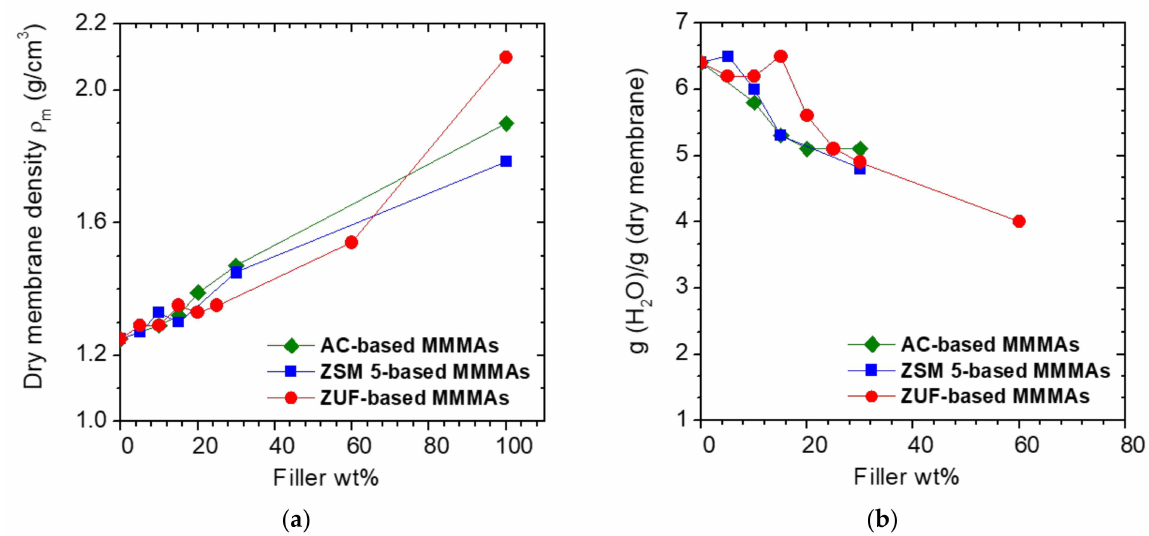
Figure 4. ( a ) Dry membrane density ρ m and ( b ) Water uptake, in grams of water per gram of dry membrane, versus filler weight percentage for the different